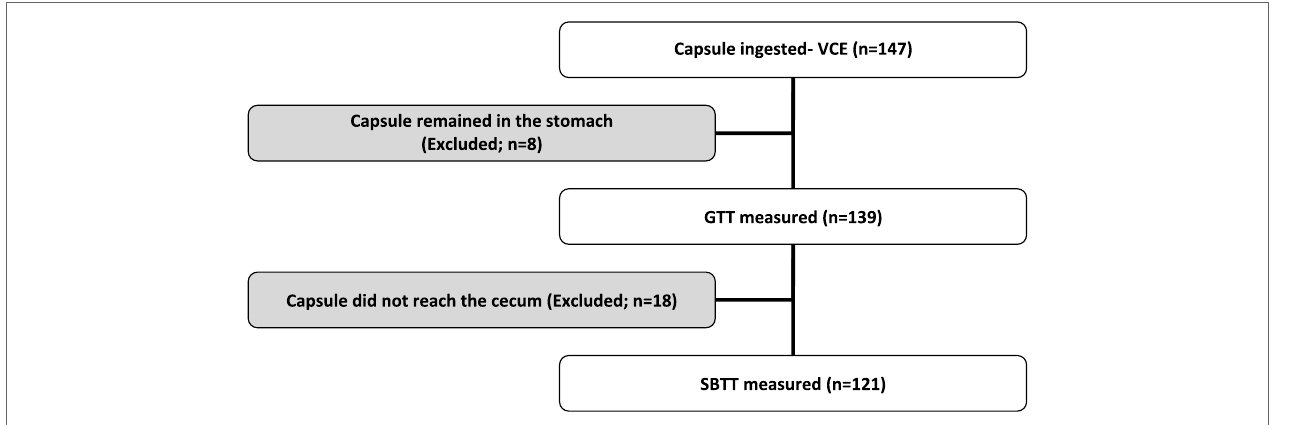
FigUre 1 | Flow diagram of patients included for gastric transit time (gTT) and small bowel transit time (sBTT) analysis